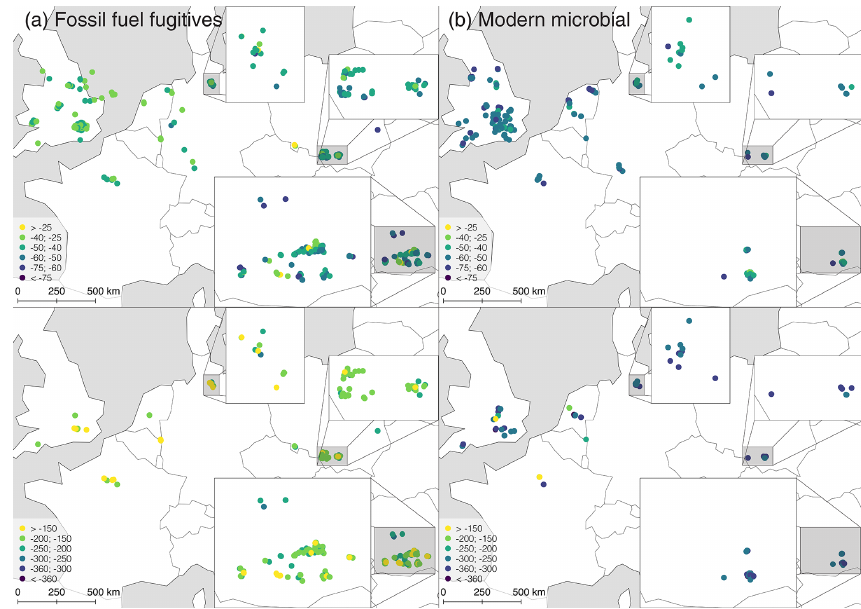
Figure 3. Measurement results of δ 13 C (top) and δ 2 H (bottom) in CH 4 from the EMID. (a) CH 4 fugitive emissions from the exploitation of fossil fuels (gas leaks, oil and gas extraction, and processing sites). (b) CH 4 emissions from modern microbial fermentation sources (ruminants, landfills, sewage treatment plants, and biogas plants).